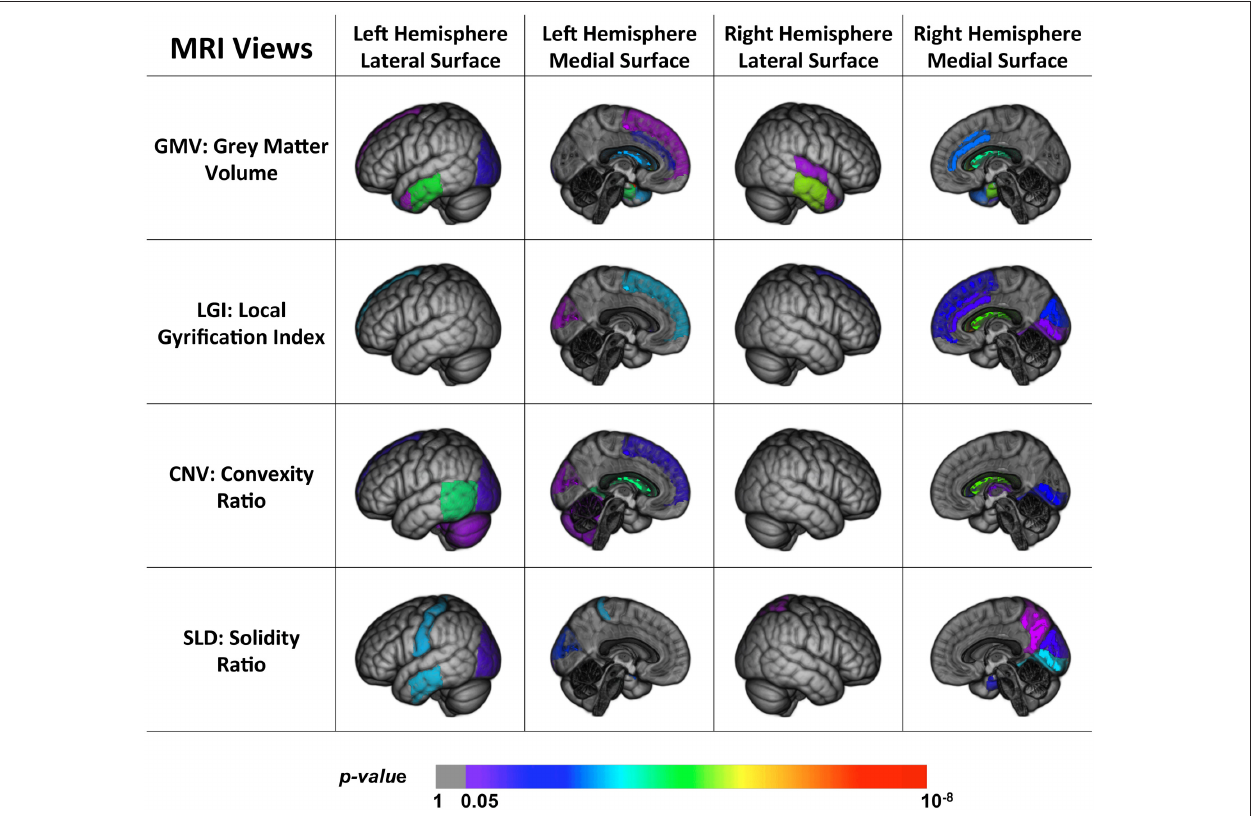
FIGURE 2 | Back projection of the normalized weights of the ROIs for four MRI views onto the ICBM_152 template using 3D Slicer (Fedorov et al., 2012